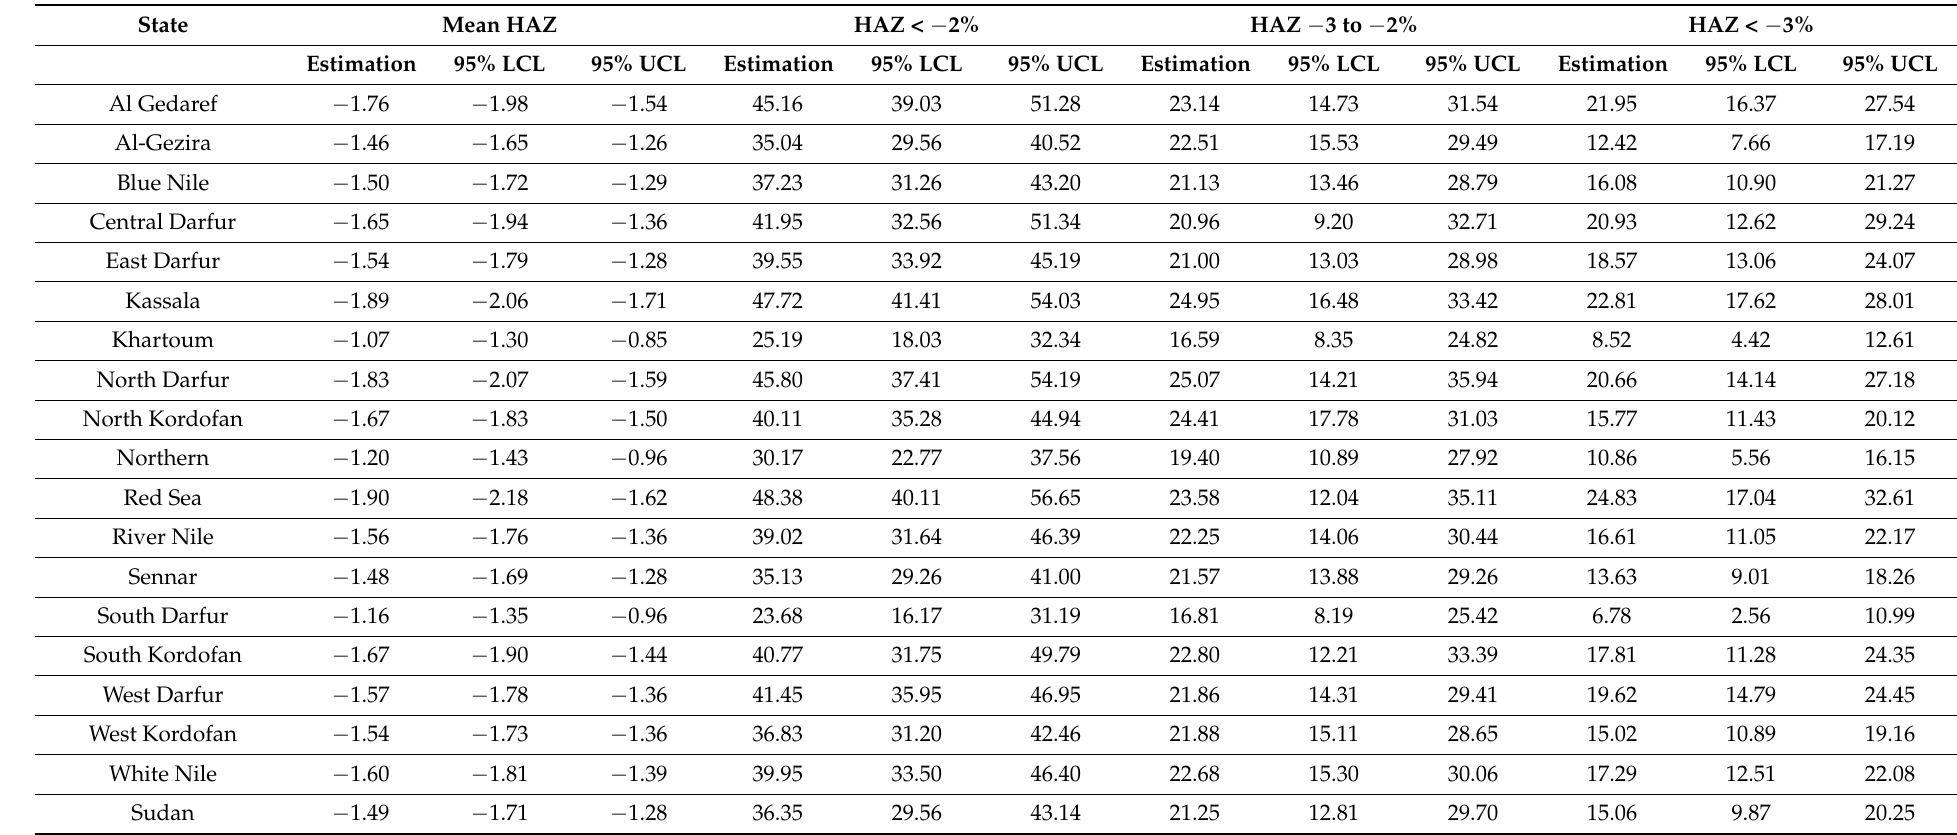
Table 2. Distribution of stunting prevalence and mean by